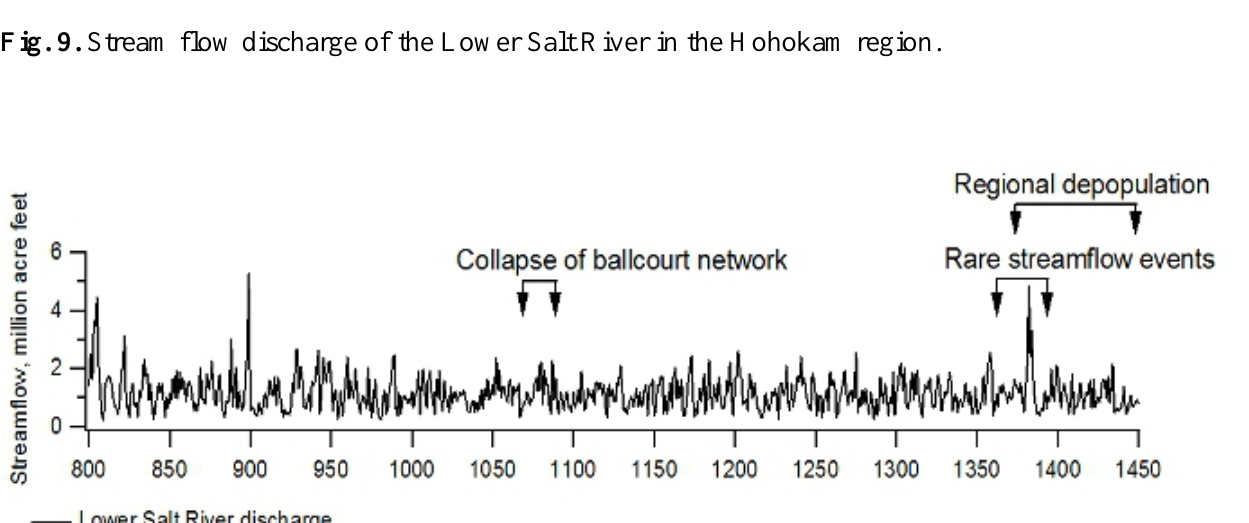
Fig. 9. Stream flow discharge of the Lower Salt River in the Hohokam